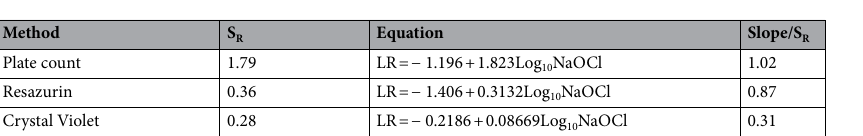
Table 3. Summary of the treatment data for each method. The table shows the S R values for the LRs pooled over all concentrations of the NaOCl treatment when applying the ILP protocols only. In addition, the equation of the regression line (shown in Fig. 2) that quantifies the dose response curve for each method. The slope in each equation quantifies responsiveness of each method, hence the column Slope/S R is a measure of the reproducibility of each method relative to the